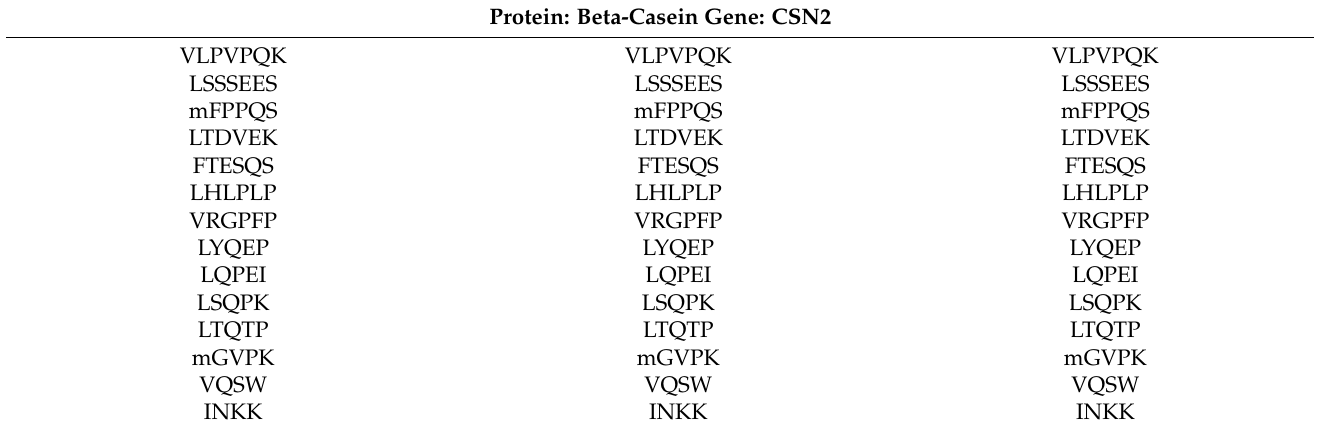
Table 2. Cont. Protein: Beta-Casein Gene: